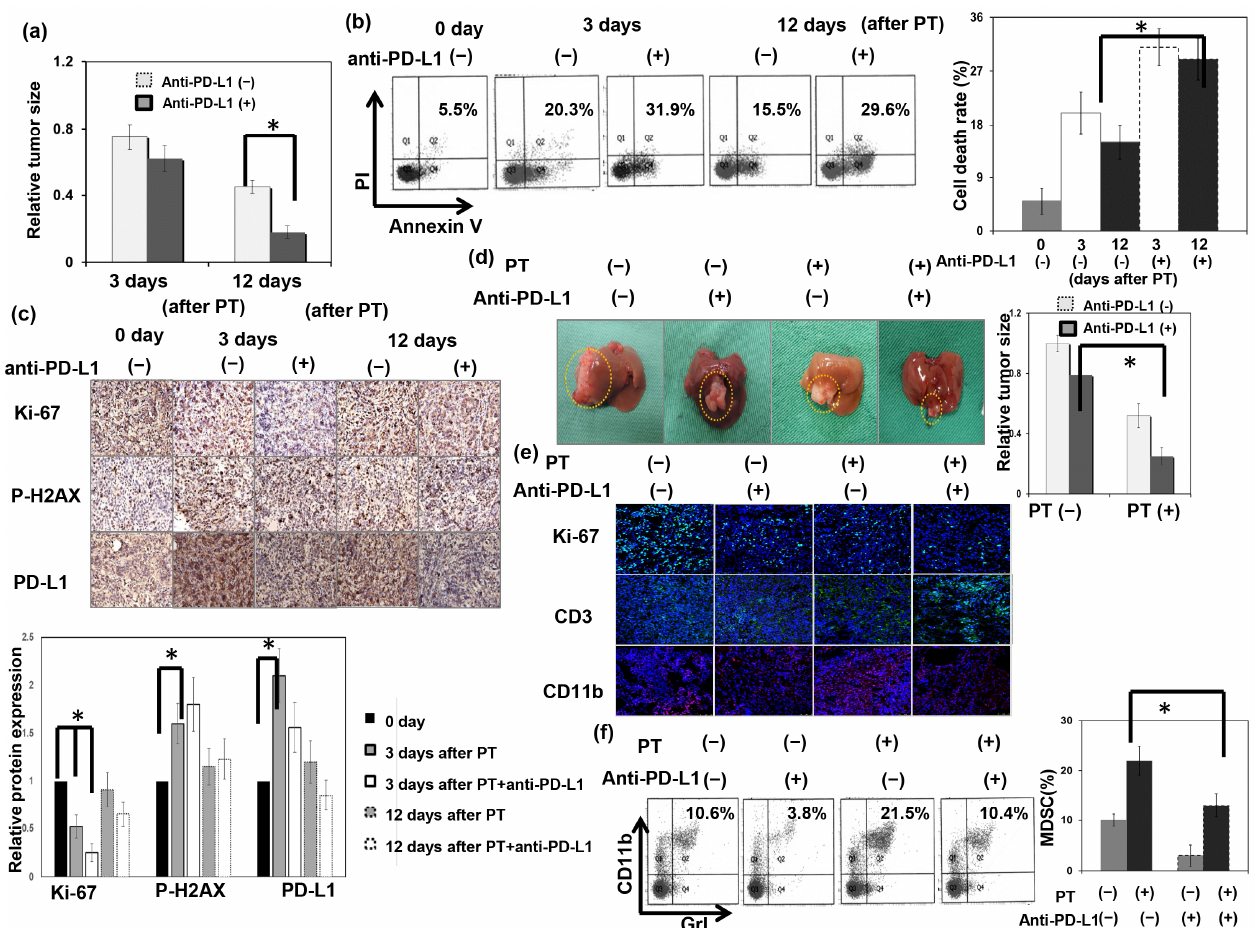
Figure 6. Effect of PD-L1 on the response of HCC to PT in vivo. ( a ) The effect of anti-PD-L1 therapy on the tumor growth delay. The y axis is the relative fold change in subcutaneous tumor size induced by anti-PD-L1 after PT. Data represent the means of experiments, * p < 0.05. ( b ) The in vivo effects of treatment-induced apoptosis as evaluated using FACS with Annexin V-PI staining. The y axis is the relative fold change in the cell death rate after PT. Data are presented as means ± standard errors of the mean. * p < 0.05. ( c ) Immunohistochemistry for RT-induced DNA damage and Ki-67 in tumors at the indicated times after PT for 12 Gy (RBE). ( d ) The effect of anti-PD-L1 therapy on tumor inhibition was evaluated in an orthotopic tumor model. Representative images and quantitative data are shown 12 days after local PT irradiation or sham irradiation. The y axis is the relative fold change in liver tumor size. Data represent the means of experiments, * p < 0.05. ( e ) The extent of ki67+, CD3+TIL, and CD11b+ cells in irradiated tumors 12 days after PT were examined using IF (DAPI, blue; ki-67 and CD3, green; CD11b, red). ( f ) The effect of anti-PD-L1 combined with PT irradiation on MDSC recruitment was evaluated using FACS.